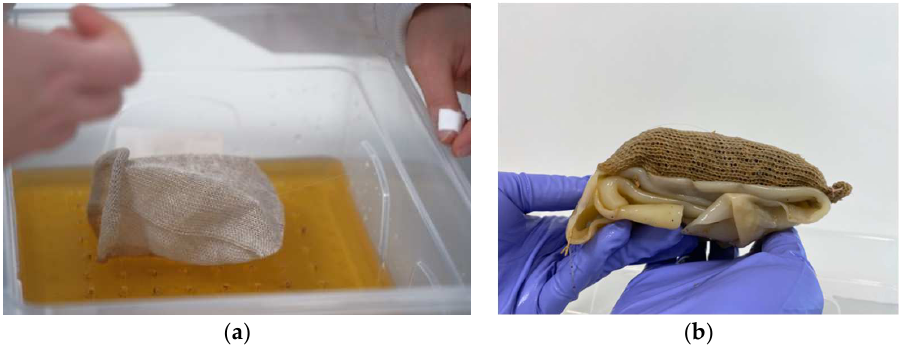
Figure 3. ( a ) The knitted pocket being placed inside the kombucha culture on top of the acrylic scaffold with the top half being lifted. ( b ) Pocket filled with pre-inoculated mycelium substrate and BC folded in 9 layers underneath (image credit: authors).